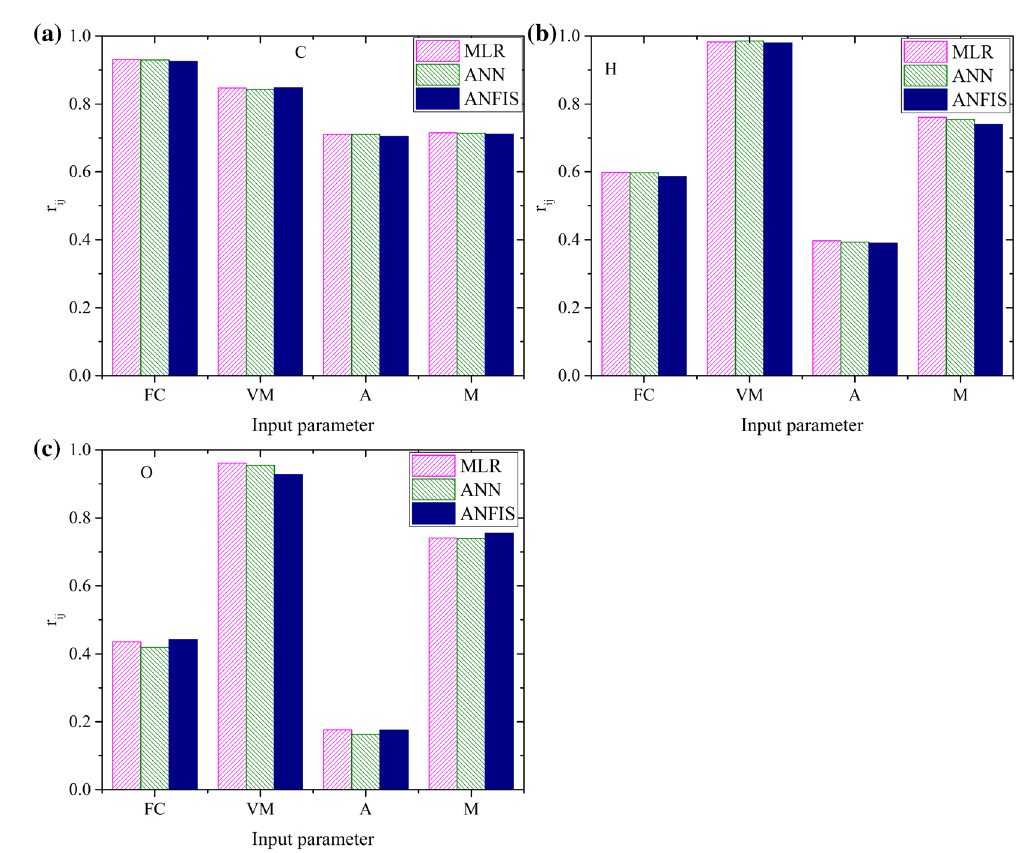
Fig. 11 Strength of the input